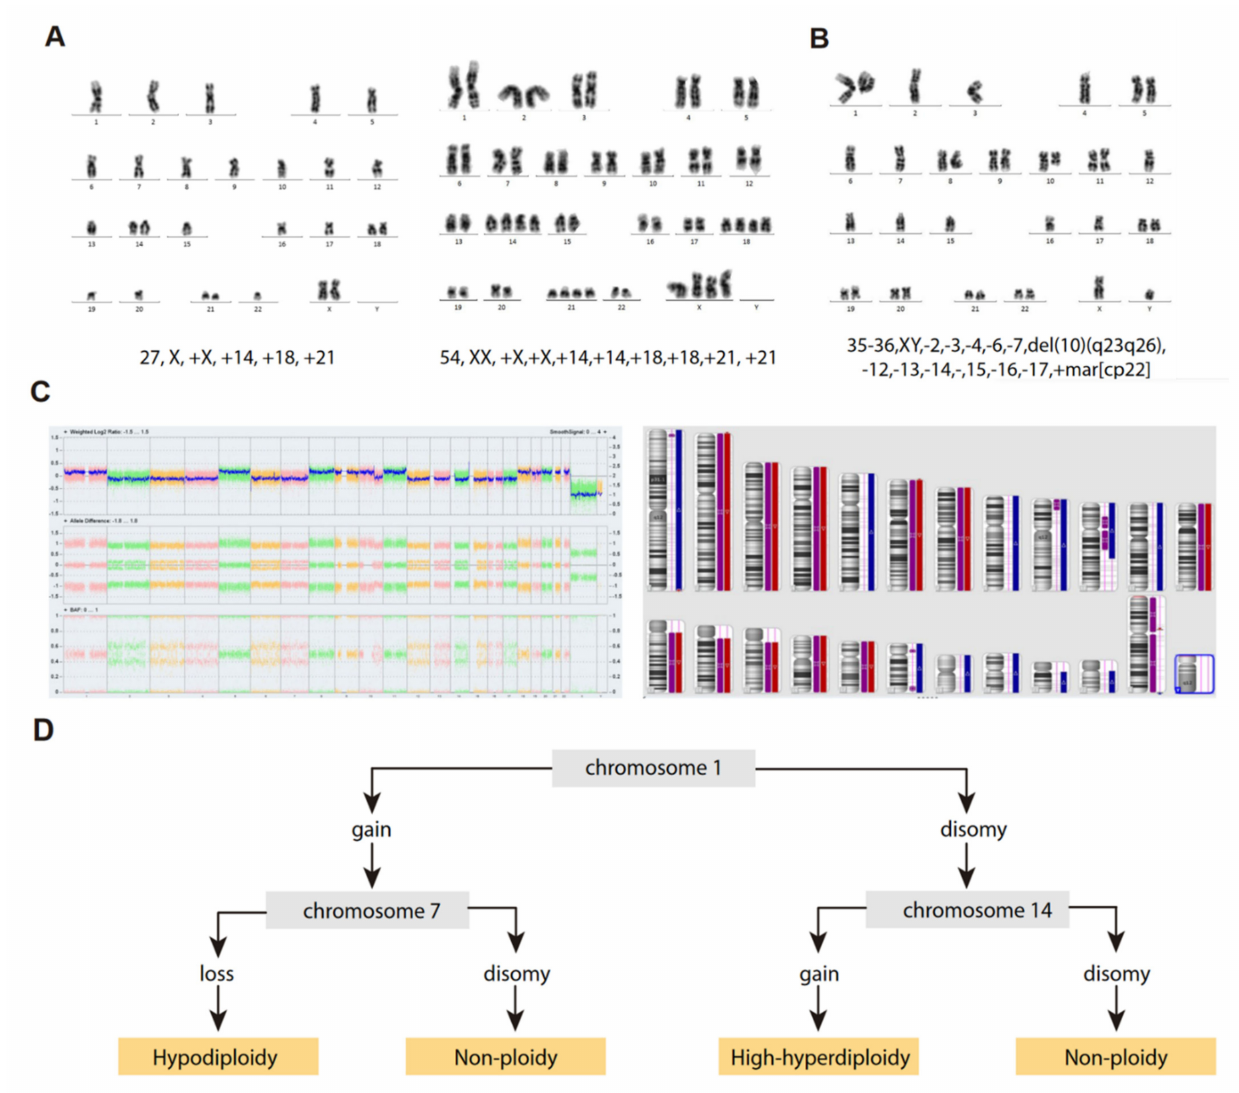
Figure 2. Cytogenetic characterization of B-ALL with <40 chromosomes. ( A ) G-banded karyotype of near-haploid B-ALL leukemic cells. Left panel , near-haploid clone. Right panel , chromosomally- doubled clone of the same patient. ( B ) G-banded karyotype of low-hypodiploid B-ALL leukemic cells. Karyotype formulas are indicated below. ( C ) SNP-array karyogram obtained for the low-hypodiploid B-ALL patient in B. Right panel , blue bars indicate chromosomal disomies of the duplicated/near- triploid clone, red bars indicate chromosomal losses, and purple bars indicate absence of heterozy- gosity. Left panel , Log2 ratio plot detailing whole chromosomal view for each chromosome, the figure demonstrates pattern of low-hypodiploidy where chromosomes with the lowest Log2 ratio represent the monosomies and a partial deletion of chromosome 10. Allele difference plot and B-allele frequency plot (BAF; BB, AB and AA alleles) indicates copy-neutral loss of heterozygosity. ( D ) Algorithm proposed by Creasey et al. [39] to distinguish hypodiploid with <40 chromosomes and high-hyperdiploid B-ALL cases based on specific chromosomal